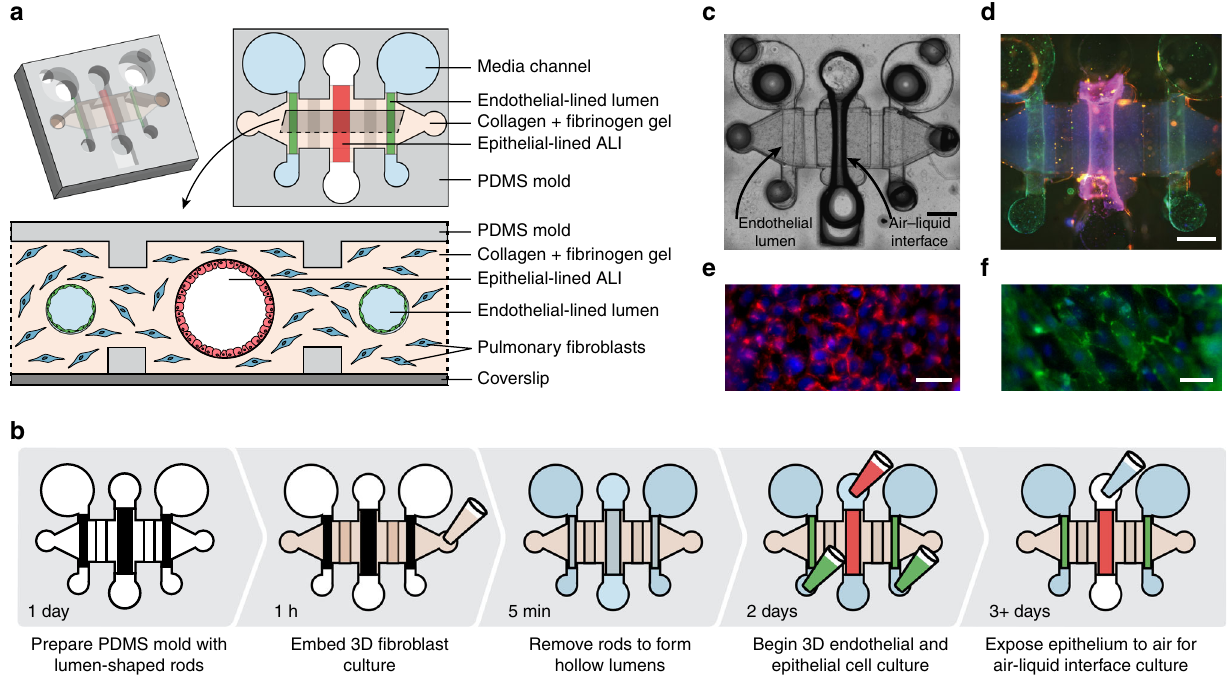
Fig. 1 Cell culture in the organotypic bronchiole model. a Schematic of the organotypic bronchiole device, including an isometric view, a horizontal section, and a vertical section. b Steps, and their associated duration, to set up organotypic bronchiole devices. c Photo of one organotypic bronchiole device with air in the center, epithelial cell-lined lumen and media in the two side, endothelial cell-lined lumens. Scale bar is 500 μ m. d Organotypic bronchiole model stained with Hoechst (blue, nuclear stain), anti-CD31 antibody (green, endothelial tight junction marker), and anti-EpCAM antibody (red, epithelial cell – cell adhesion maker). Scale bar is 500 μ m. e Magni fi ed image of the epithelial cell monolayer present in the center lumen from d , scale bar is 200 μ m. f Magni fi ed image of the endothelial cell monolayer present in the side lumens from d . Scale bar is 200 μ